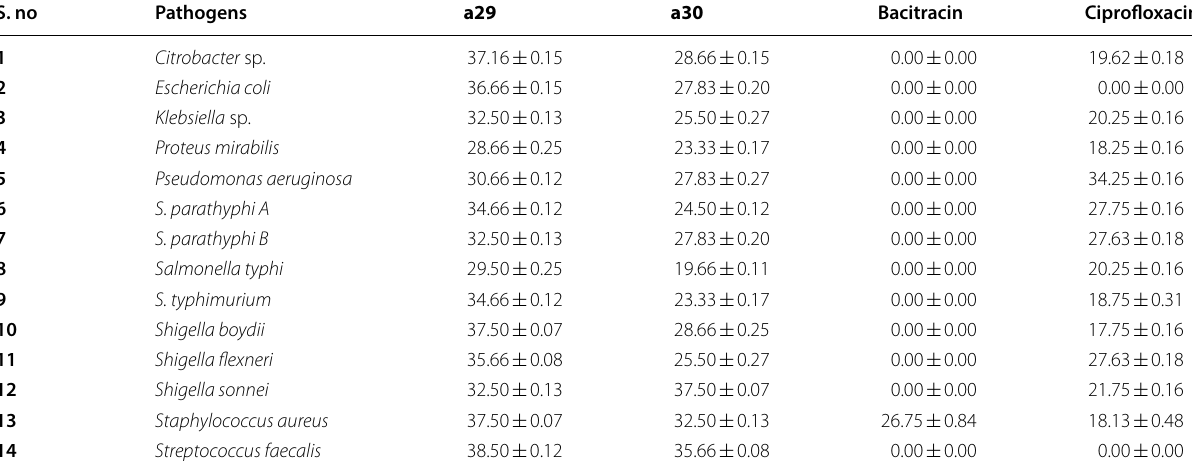
mm) of most active compounds =